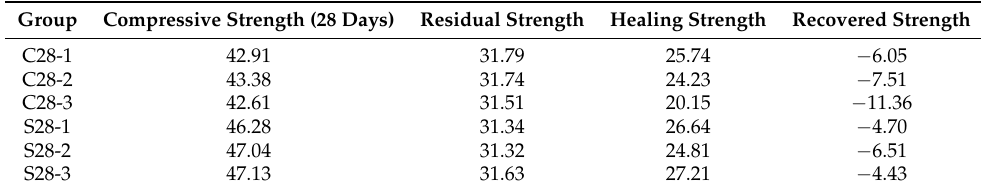
Table 4. Compressive strength of the two ECC mixtures recovered after standard curing (28 days). (unit: MPa).